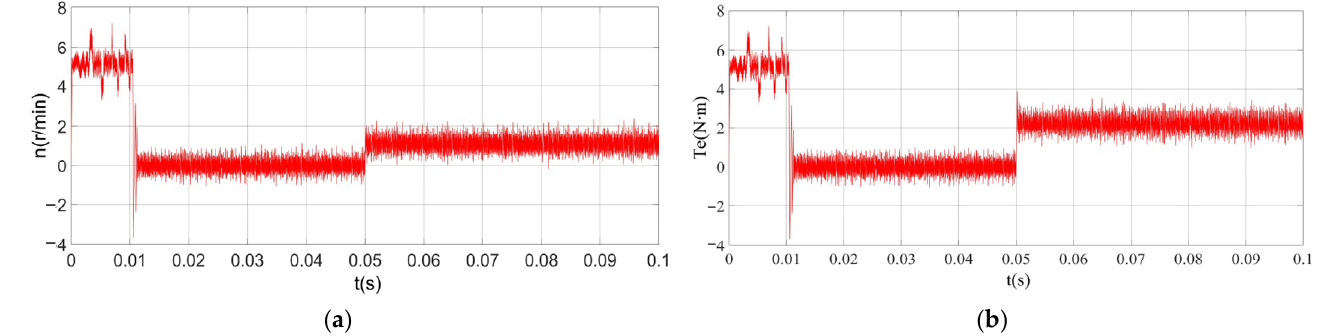
Figure 13. Torque p erformances of MPTC2 under different loads with speed of 7000 r/min: ( a ) 1.1 N·m; ( b ) 2.2 N·m.